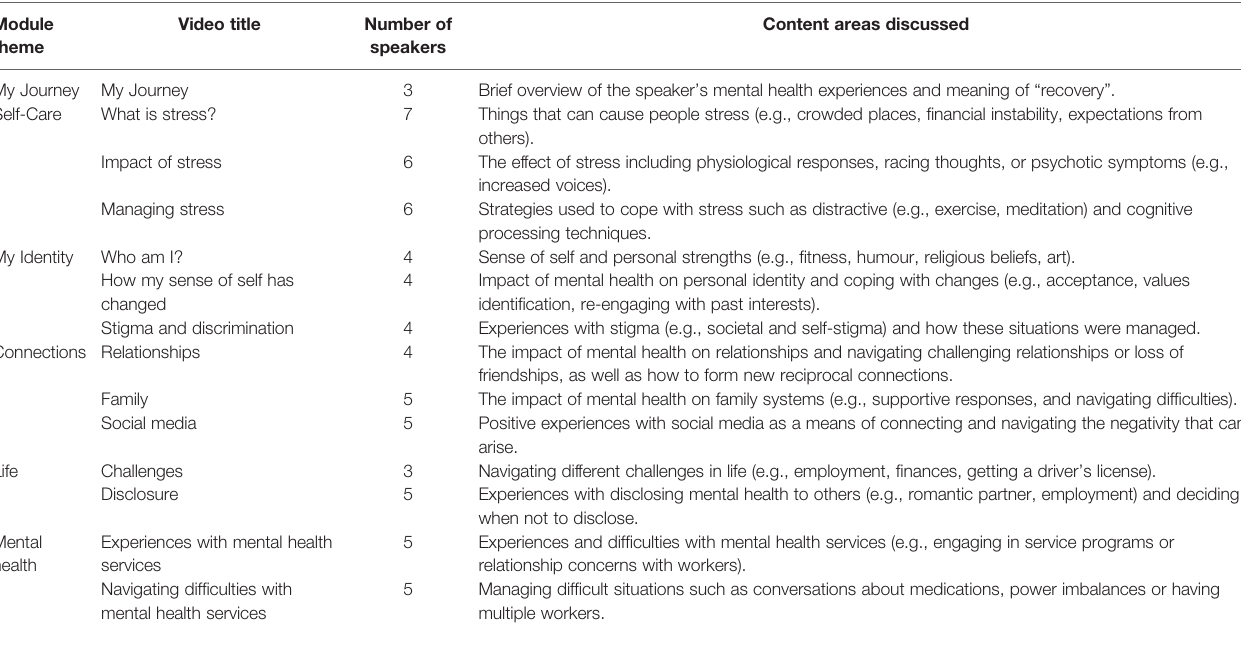
TABLE 1 | Summary of the lived experience videos